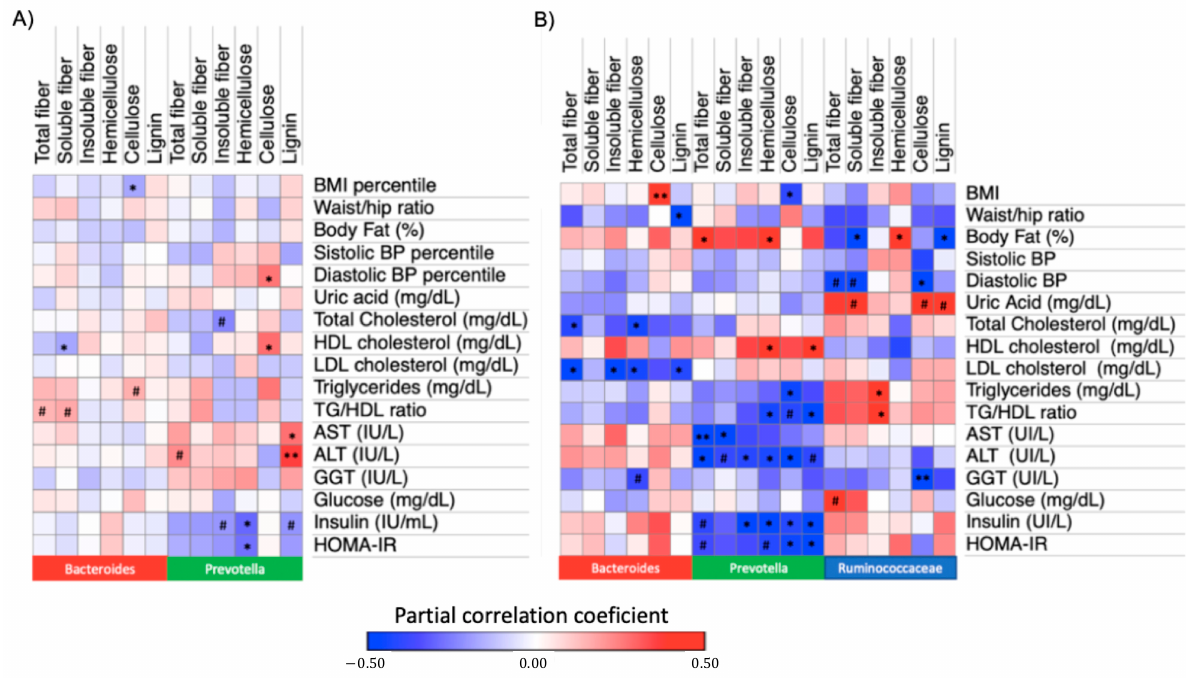
Figure 2. Correlations between DF intake and metabolic traits within enterotypes for ( A ) children and ( B ) adults. Heatmap represents partial Spearman correlations between daily DF intake (adjusted per 1000 kcal) and metabolic traits. Correlations with anthropometric traits were adjusted by sex and age, while correlations with biochemical variables were further adjusted for body fat percentage. # p < 0.10, * p < 0.05 and ** p < 0.01.